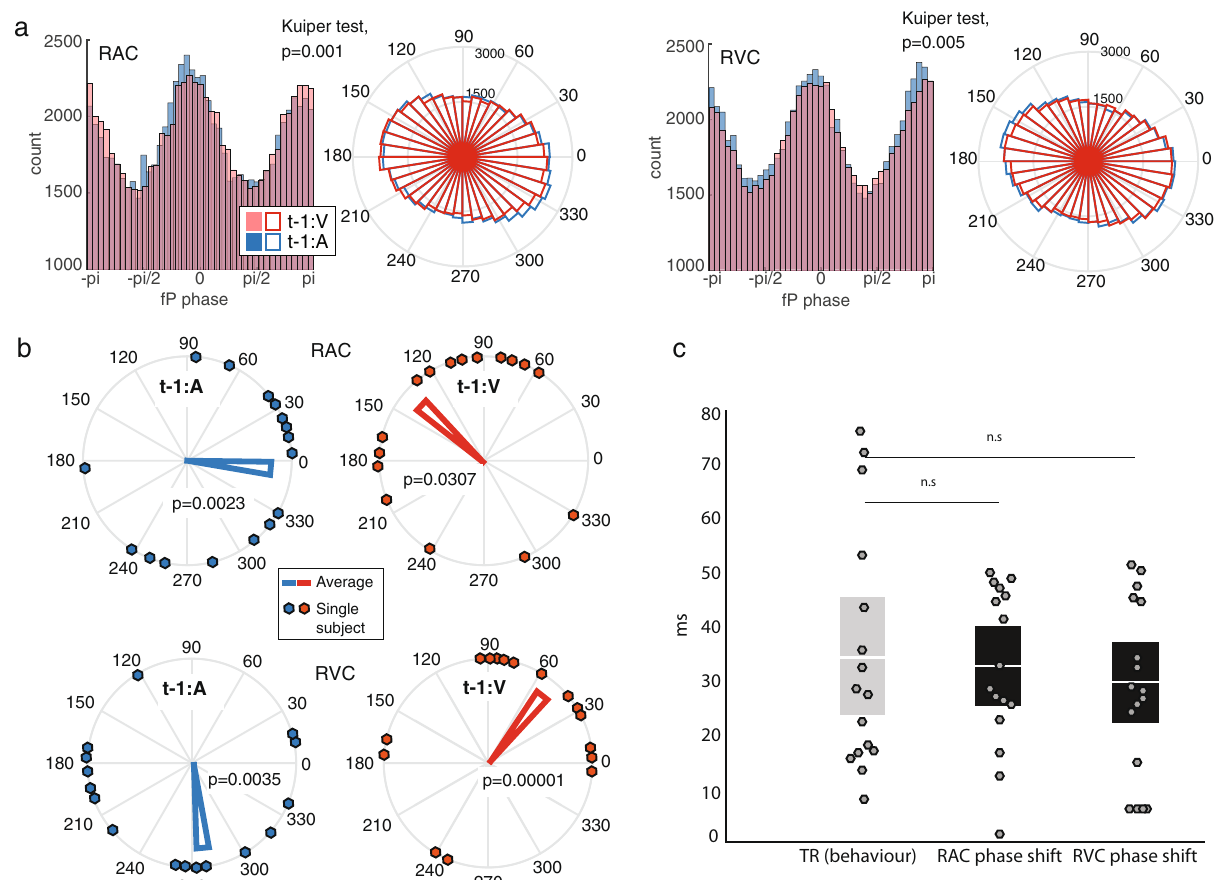
Fig. 6 Modality order on the previous trial modulates preferred coupling phase. a Histogram and rose plots show the empirical distribution of single-trial preferred phase angles of PAC along the fP cycle, for trials with visual lead on the previous trial (t-1:V; red) and those with auditory lead (t-1:A; blue) extracted from all MEG sources within RAC and RVC and pooled across participants ( n = 16). The Kuiper test assessed whether the two circular distributions were signi fi cantly different. b Rose plots show the distribution of individual preferred phase angles (dots) and the group circular average of PAC preferred phase φ of fA oscillations along the fP cycle. Data from trials with visual lead on the previous trial (t-1:V condition) are shown in red and those with auditory lead (t-1:A condition) are shown in blue, in RAC (top) and RVC (bottom). Rayleigh tests assessed uniformity of phase angle distributions across subjects around the unit circle (p-values are displayed). c The PAC phase shifts measured between conditions in the auditory (left black bar; RAC) and visual (right black bar; RVC) cortex, once converted to milliseconds from phase angles along the fP cycles (Equation 1), were statistically identical on average to the empirical values of temporal recalibration (gray bar; TR), (both with p > 0.5; two-sampled paired t tests). Dots represent single-subject data ( n =